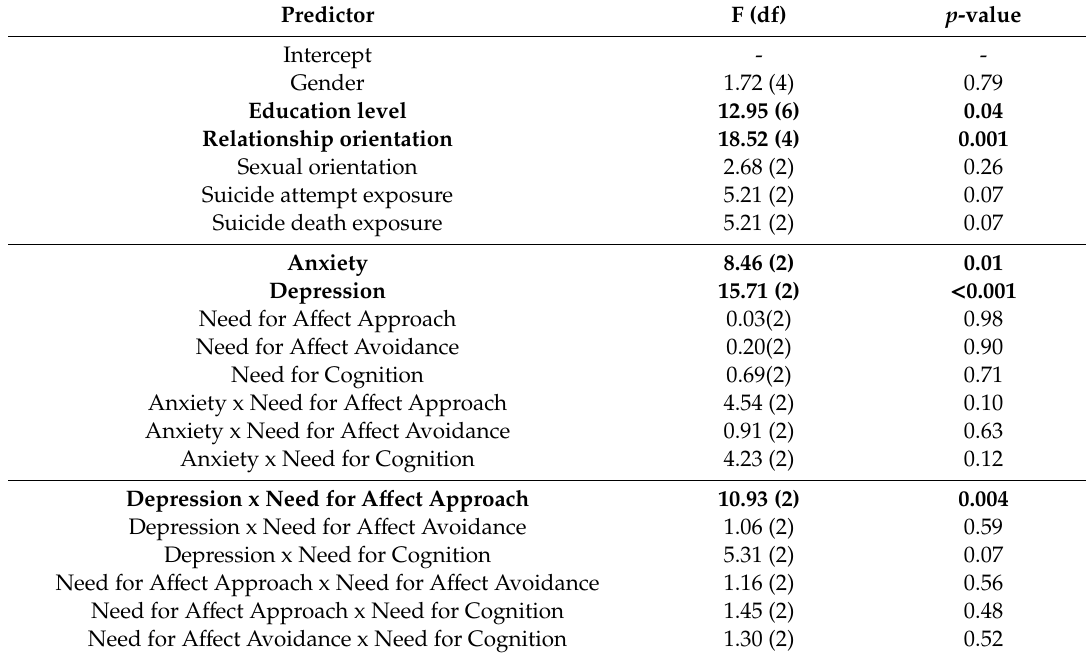
Table 3. Multi-nomial regression model of lifetime suicide-related behavior group